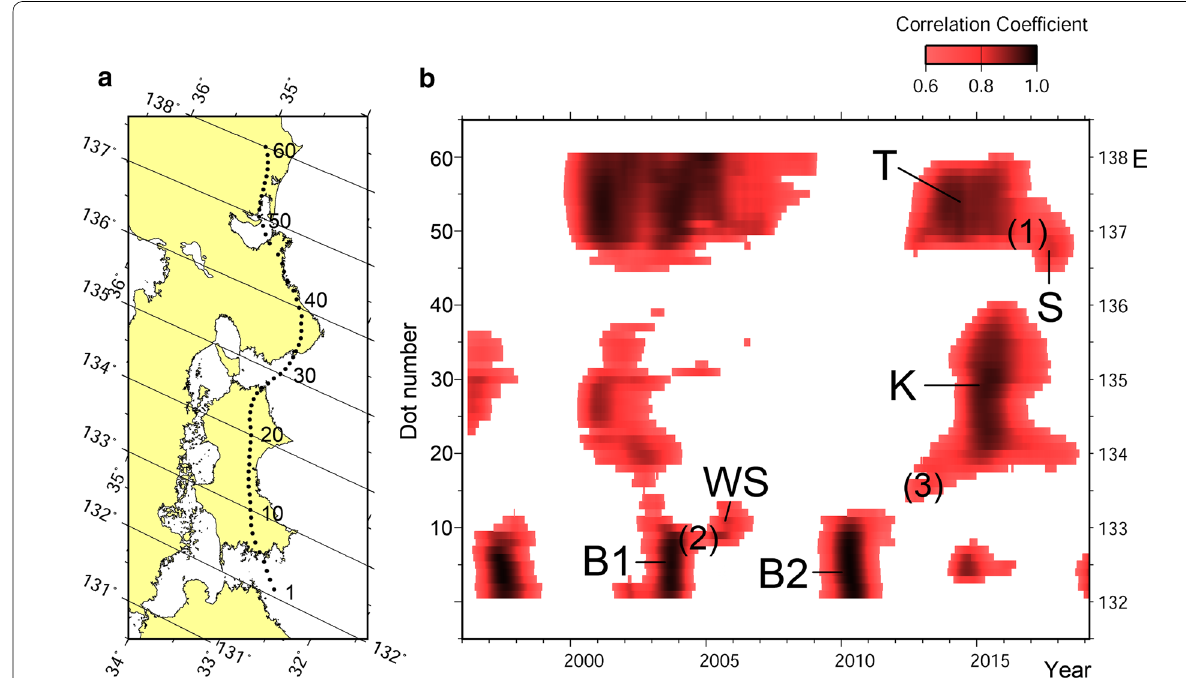
Fig. 2 Detection of long-term SSEs. a Map showing locations (dots 1–60) at ~ 25 km depth on the Nankai Trough subduction interface. b Time-longitude (dot number) plot showing displacements during long-term SSEs within 100 km 50 km rectangles centered on dots 1–60. × Colored regions have correlation coefficients greater than 0.6 and 2-year displacements greater than 2 mm. See the text for details. T: Tokai long-term SSE (Ozawa et al. 2016), S: Shima Peninsula (this study), K: Kii Channel (Kobayashi 2017), WS: western Shikoku (Kobayashi 2010), B1, B2: Bungo Channel (Ozawa et al. 2007; Ozawa et al. 2013). Labels (1), (2) and (3) indicate migrations discussed in the text. The data record ends in February 2019; note that results for latest 1.5 years may change as later data are